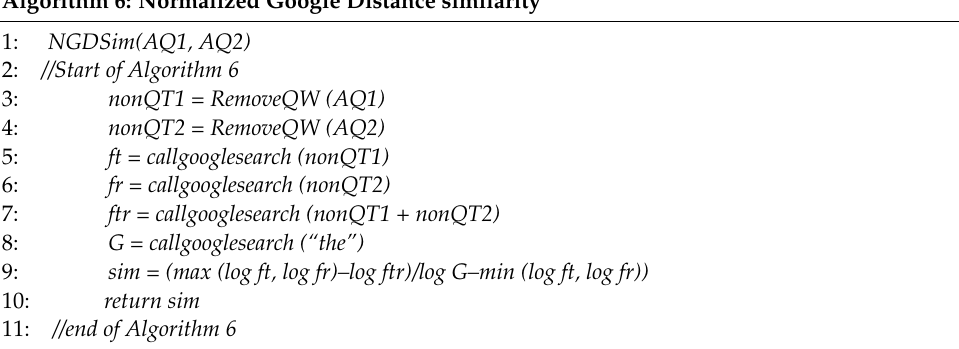
Algorithm 6: Normalized Google Distance